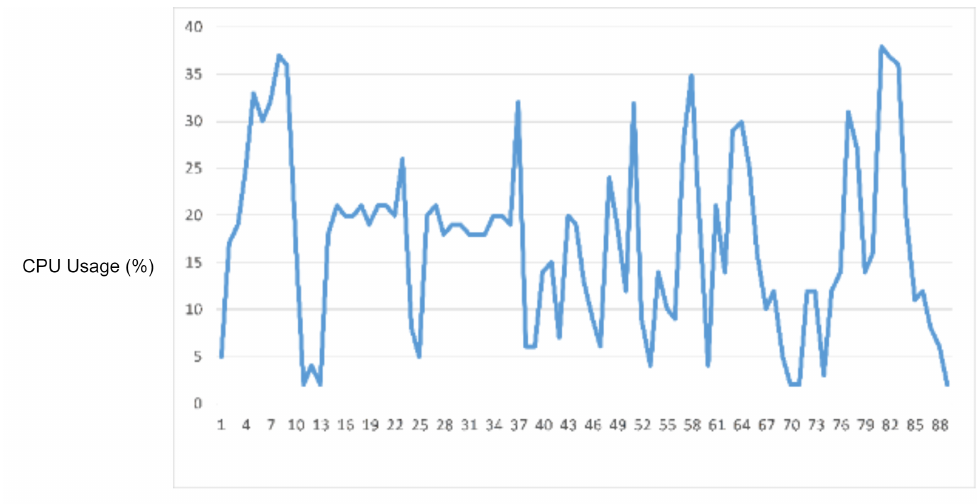
Figure 12. CPU usage captured while testing the logical error check vulnerability.